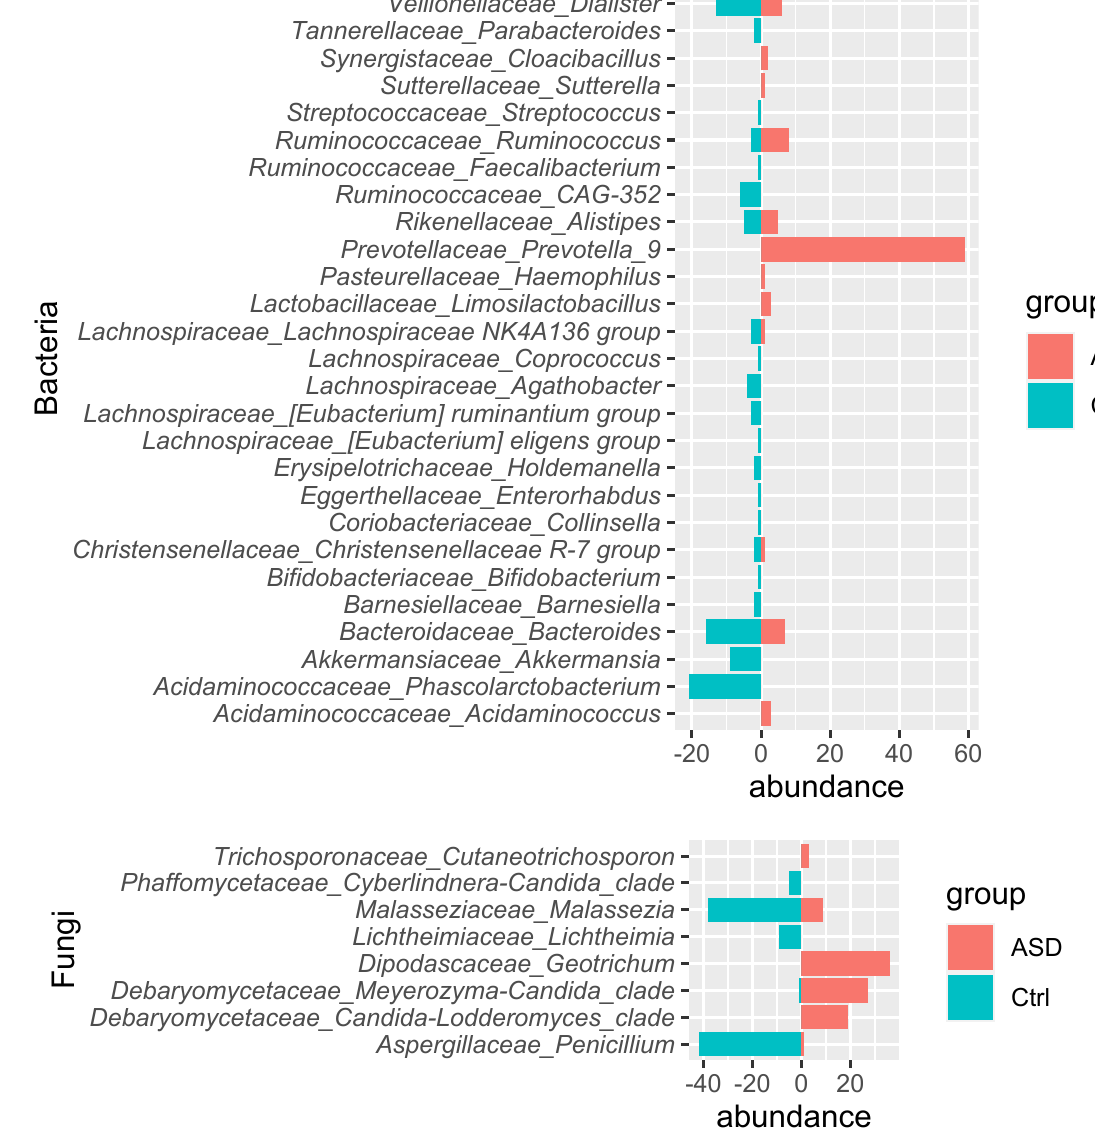
Figure 3. Bacteria ( up ) and fungi ( down ) genera relative